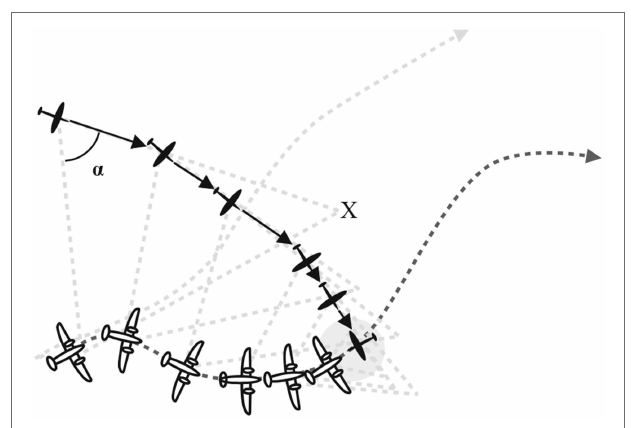
FIGURE 4 | British controllers relied on the gaze heuristic to direct fighter planes to intercept German bombers. From Hamlin